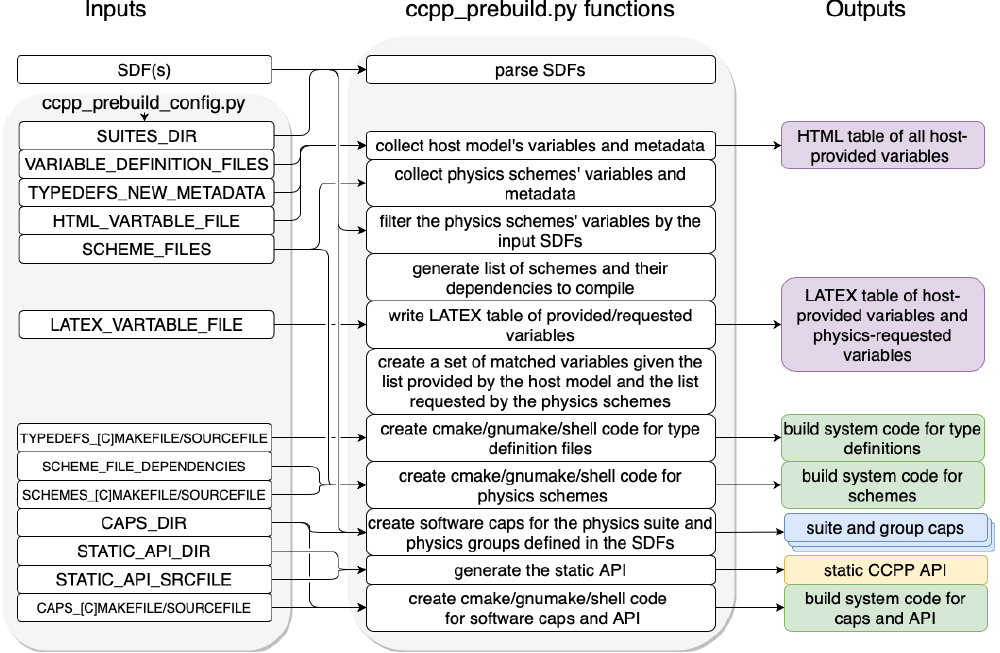
Figure 4. Flowchart of the CCPP Framework code generator ccpp_prebuild.py with its inputs and outputs.